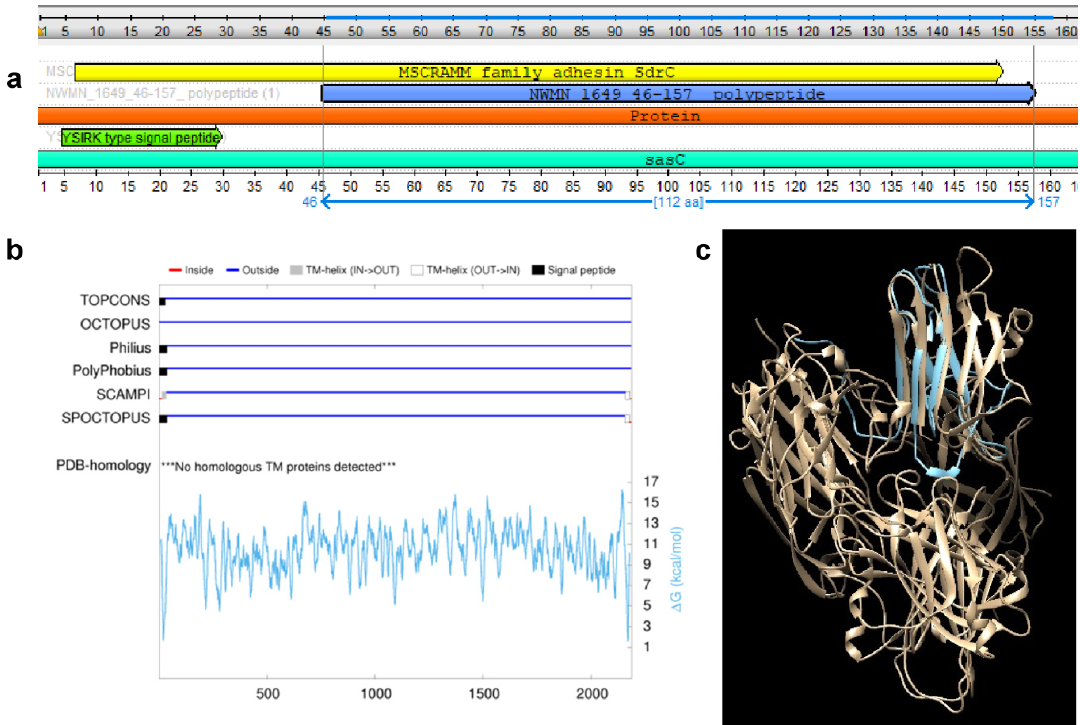
Figure 2. Conserved domains and topology of the NWMN_1649 polypeptide. ( a ) Graphical representation of the first 160 aa from the N-terminal side of NWMN_1649 showing the YSRIK signal peptide domain followed by MSCRAMM family adhesin SdrC domain and the target peptide NWMN_1649 (46–157) is highlighted, the figure was generated from the NCBI conserved domain database. ( b ) Topology prediction of the NWMN_1649 whole protein as determined using the protein topology prediction tools TOPCONS and CCTOP (Consensus Constrained TOPology prediction web server); black boxes indicate the signal peptide, the gray boxes indicate transmembrane helix (in to out), and the blue lines indicate that this sequence is predicted to be extracellular. ( c ) Homology modelling of the NWMN_1649 whole protein with the target peptide (46–157) highlighted in blue being predicted to be surface-exposed and